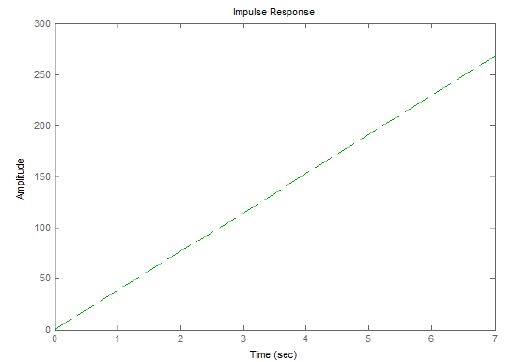
Figure 5. Impulse Response for the Open Form